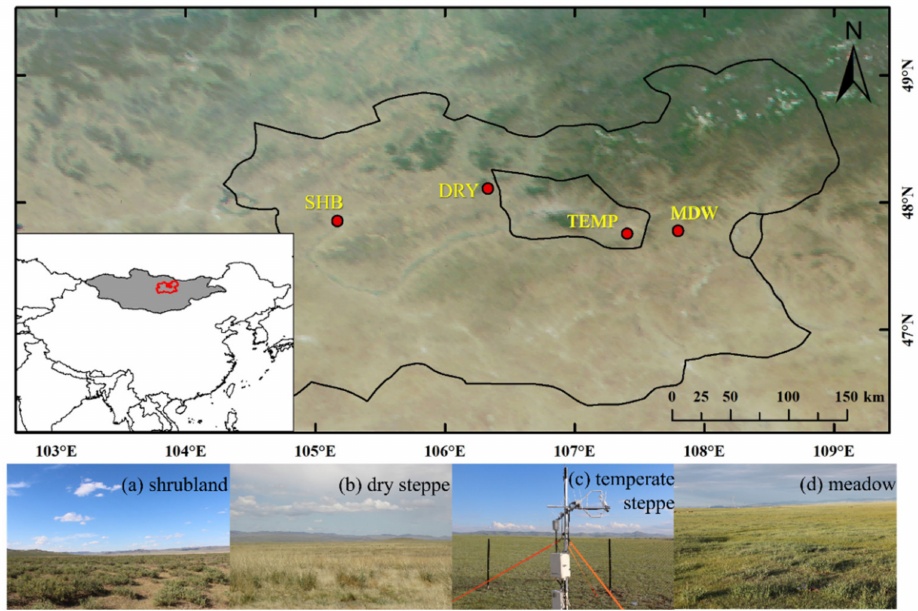
Figure 1. Locations of four eddy covariance measurement sites in Mongolia: ( a ) shrubland (SHB), ( b ) dry steppe (DRY), ( c ) temperate steppe (TEMP), and ( d ) meadow